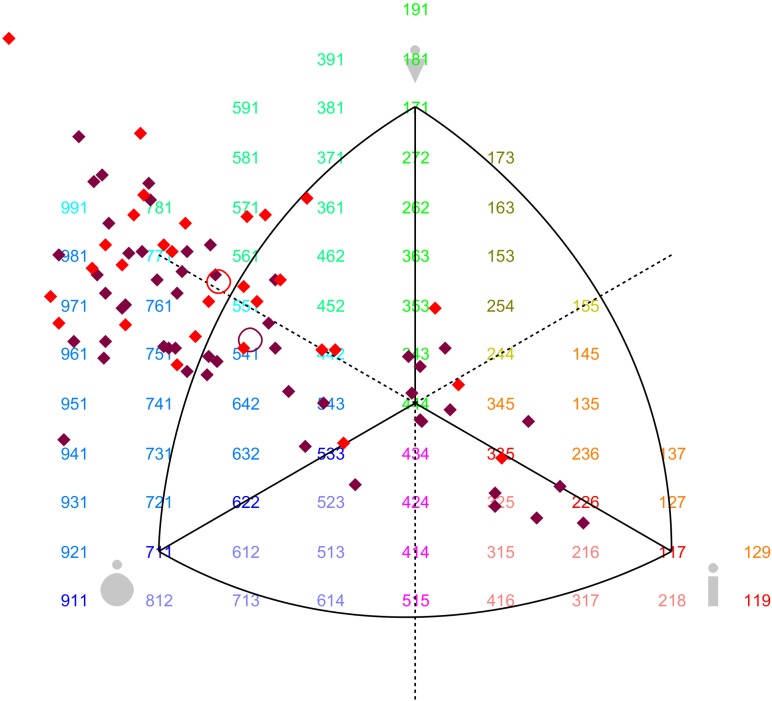
Somatotype profiles of female candidates as models for the BSS.In somatocharts, mesomorphy is represented by the vertical axis pointing upward; endomorphy by the horizontal axis pointing to the left; and ectomorphy by the horizontal axis pointing to the right. The red diamonds represent Cameroonian females and the purple ones Senegalese females. The red circle indicates the mean profile of Cameroonians and the purple one the mean profile of Senegalese.